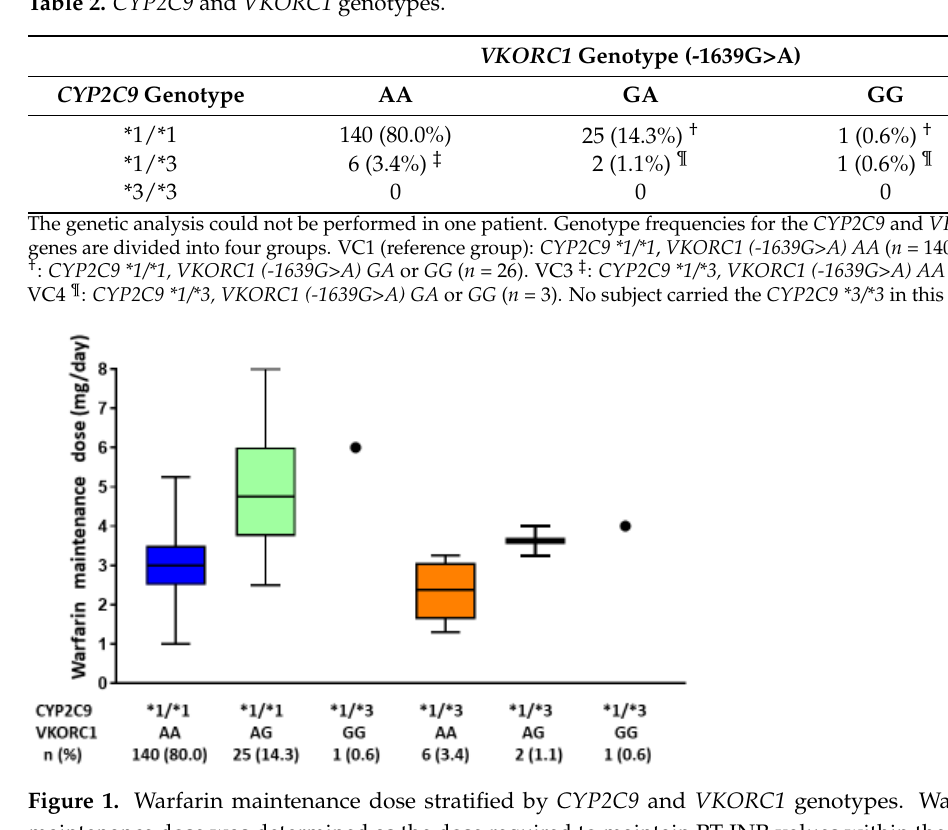
Table 2. CYP2C9 and VKORC1 genotypes.